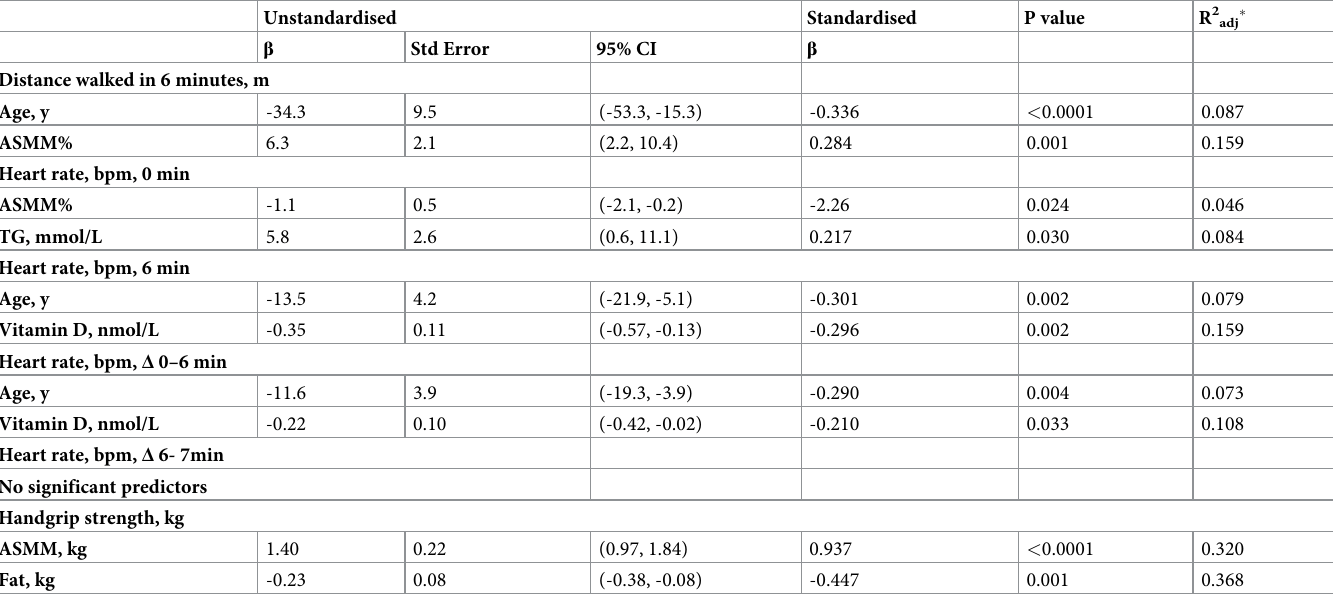
Table 4. Multiple regression analyses for prediction of physical function for 98 girls. Unstandardised Standardised